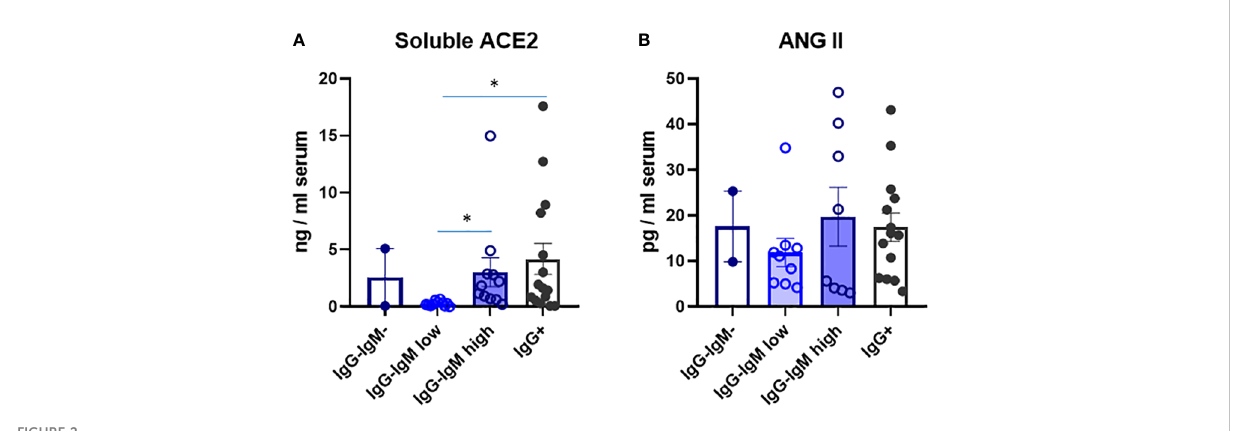
FIGURE 2 Levels of soluble ACE2 (A) and ANG Il (B) in serum of children according to their immunological status. Serum levels were analysed by ELISA as described in methods in the indicated four groups: IgG - IgM, IgG - IgM low , IgG - IgM high , IgG + . Results shown are the mean values of one duplicate experiment of the 2 independent performed with similar qualitative results.